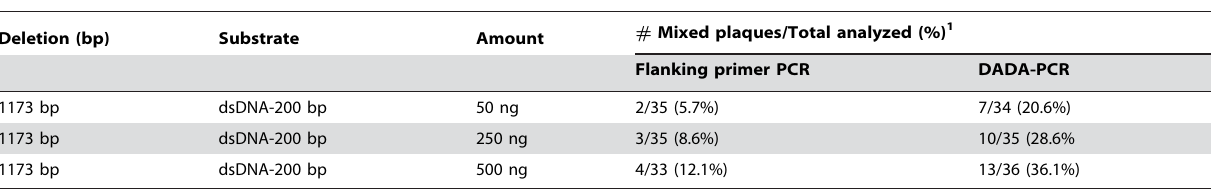
Table 2. BRED frequencies for the construction of a Giles lysA D